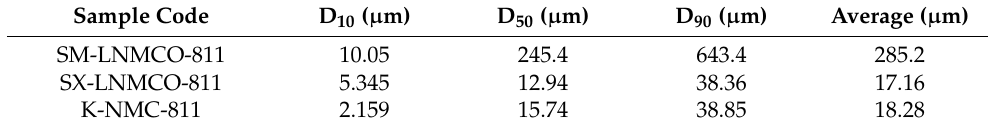
Table 7. Results of particle size measurements of the precursors using PSA.